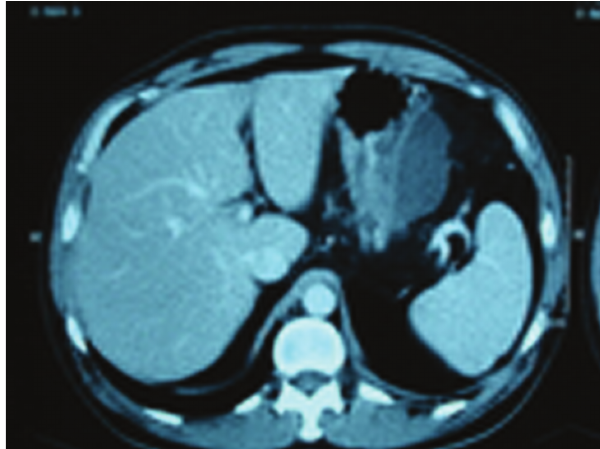
Figure 2 - Computed tomography showing the gastric wall abscess.